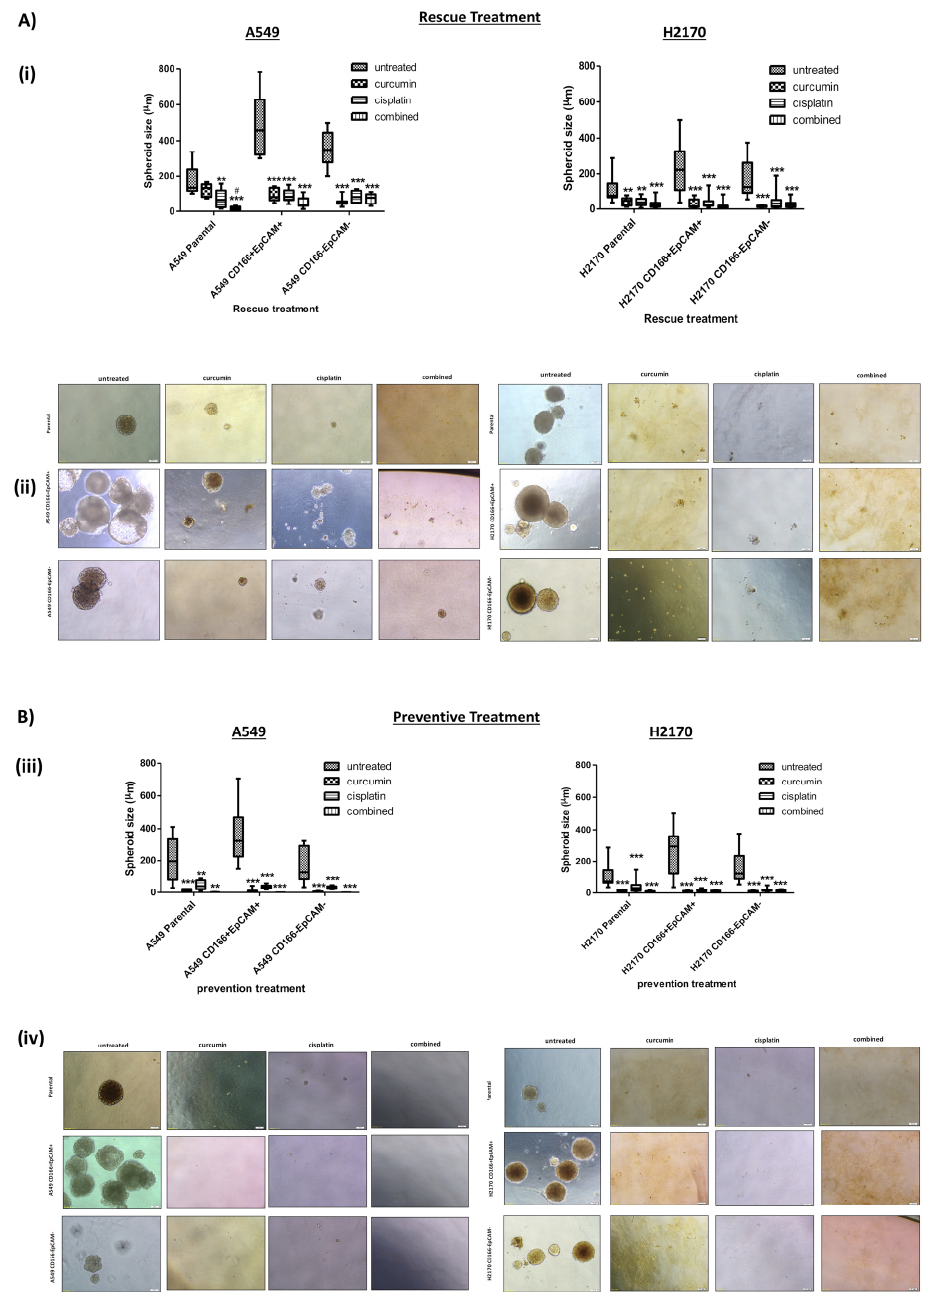
Figure 4. ( A , B ): Curcumin inhibits the spheroid formation of the CD166 + EpCAM + CSCs subpopulation and A549 CD166-EpCAM- non-CSCs subpopulation of A549 and H2170 cells in rescue ( A ) and preventive ( B ) treatment groups. ( i ) Boxplot illustrated the sphere size analysis. Upper and lower boxplot margins represent the interquartile range, and the middle bar indicated the median. The whisker defines the range of values. ( ii ) Representative photomicrographs of spheroid formation are presented for both CD166 + EpCAM + CSCs subpopulation and A549 CD166-EpCAM- non-CSCs subpopulation of A549 and H2170 cells at × 20 magnification. In the rescue treatment group, spheroid cells were treated with single and combined treatment and were evaluated after day-21. While in the preventive treatment group, cells were treated with either single or combined treatment after 72 h of cultured and were continued growing the colonies until 14 days before staining. Each bar represents the average mean ± SD of triplicate samples. Statistical significance was measured with the two-way ANOVA. ** p < 0.01, *** p < 0.001 compared with untreated cells. # p < 0.05 compared with curcumin